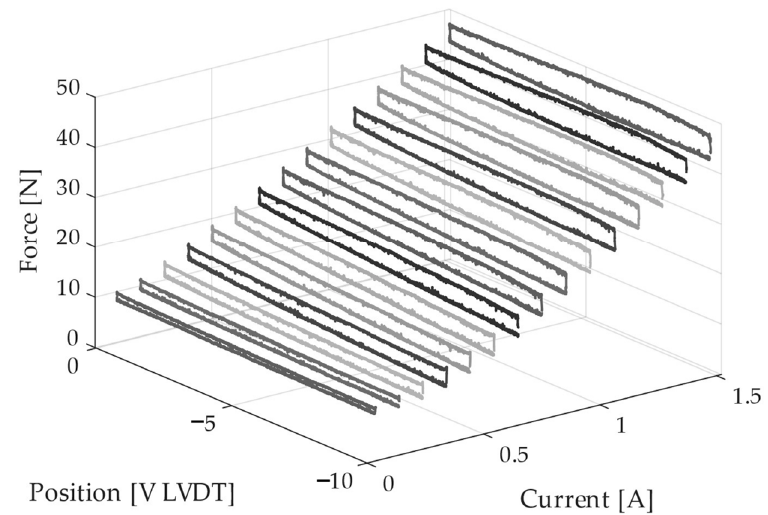
Figure 8. Measured Force Characteristics of a Solenoid.